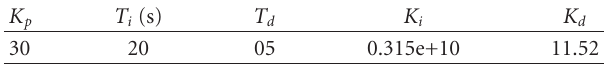
Table 3: Minimum setting values K p , K i , and K d .